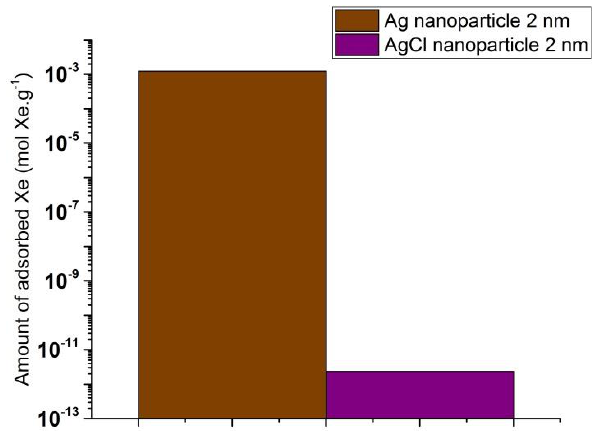
Figure 3. Simulation of the xenon adsorption capacity at 5 ppm (298 K) on silver ( brown ) and silver chloride ( purple ) nanoparticles. Plot is indicated in a log scale.